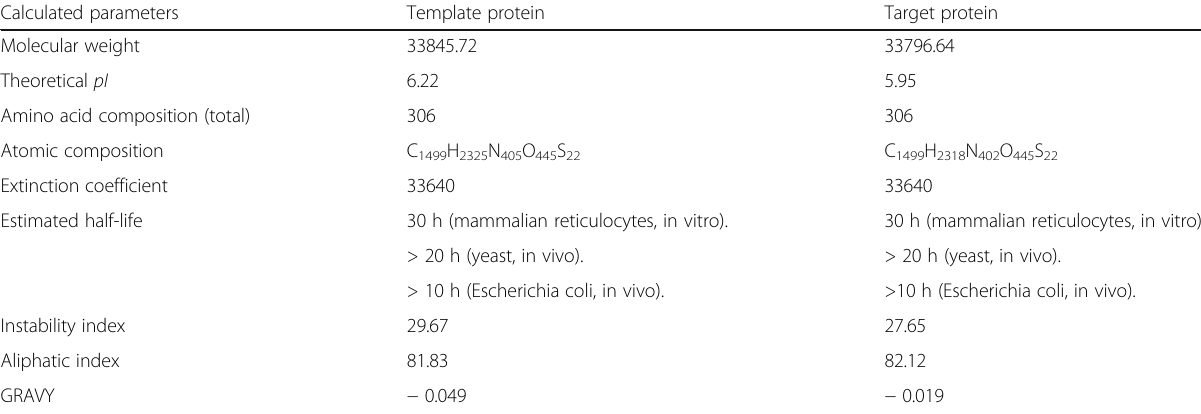
Table 4 Calculated physiochemical properties by the ExPASy ProtParam server Calculated parameters Molecular